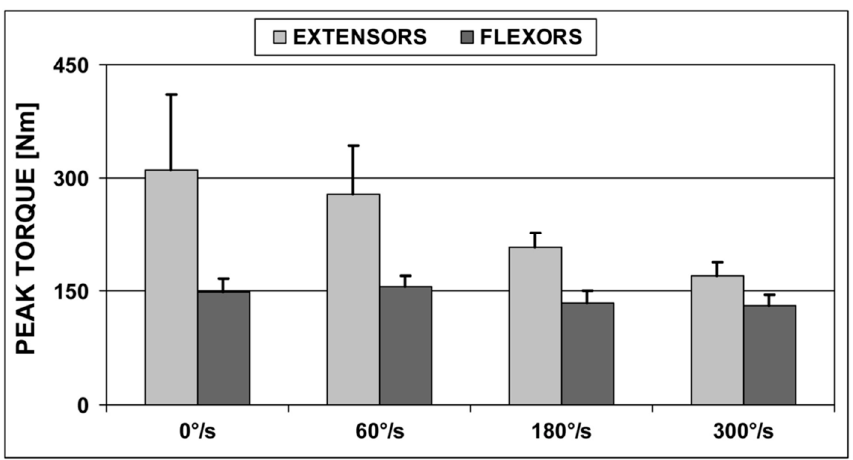
Figure 1. Changes in the peak torque of the right limb as a function of the angular velocity of the knee joints of players. Table 3. Flexor/extensor ratio obtained from an isokinetic test with concentric